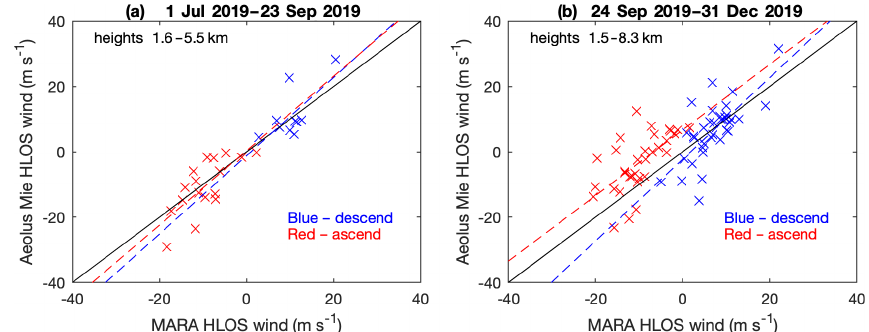
Figure 6. The same as Fig. 3 but for Aeolus Mie HLOS winds against MARA.